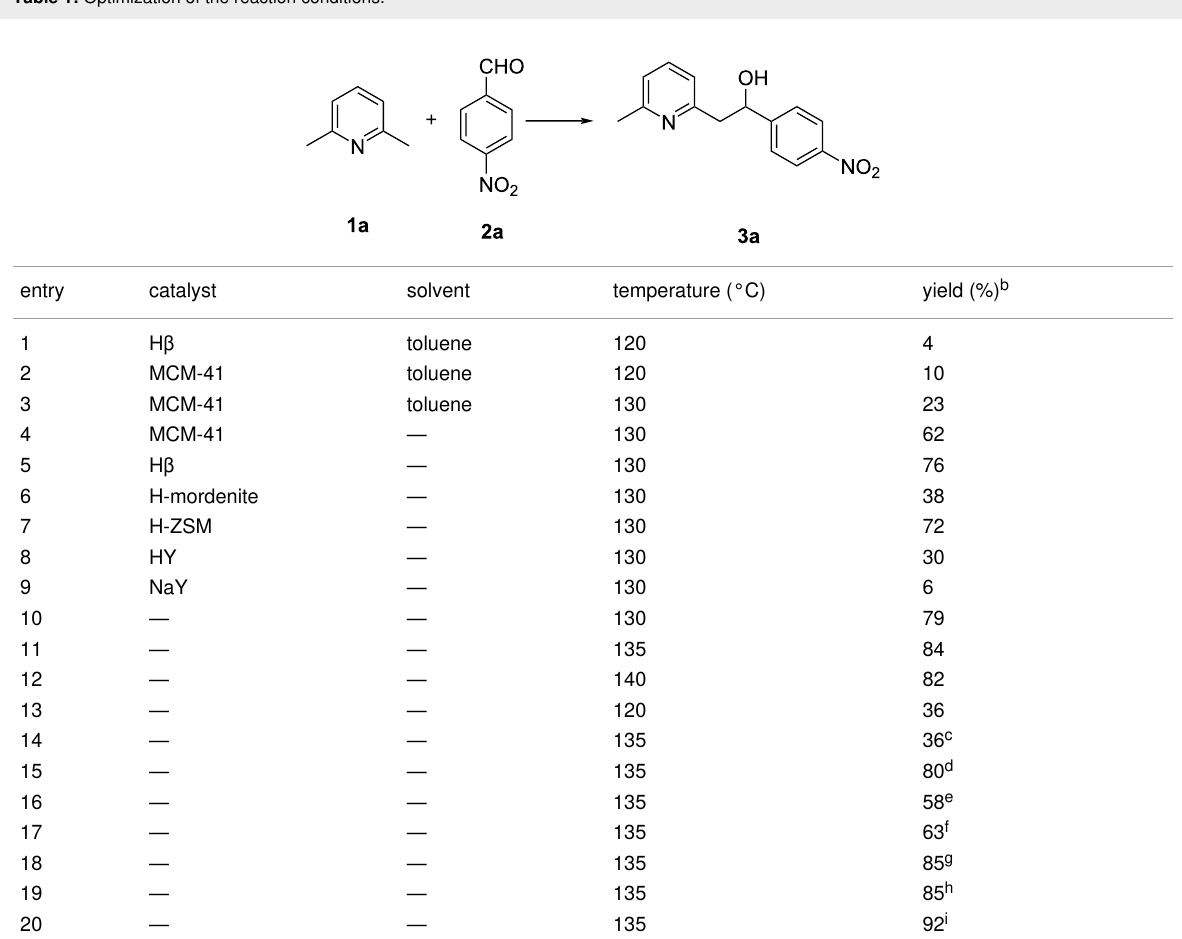
Table 1: Optimization of the reaction conditions.